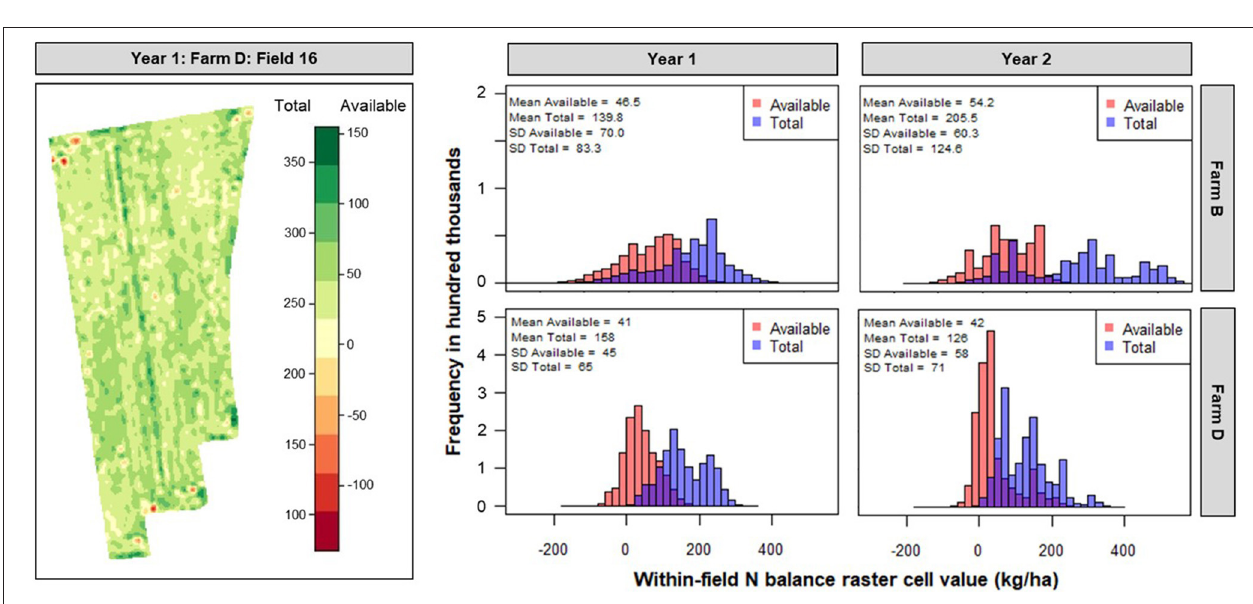
FIGURE 5 | Within-field nitrogen (N) balance map (single field example) and histograms for all within-field available and total N balances for study farms B and D for 2 years.